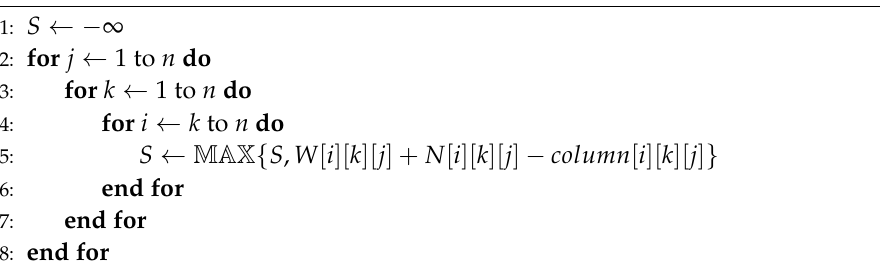
Algorithm 6 Combining W and N .